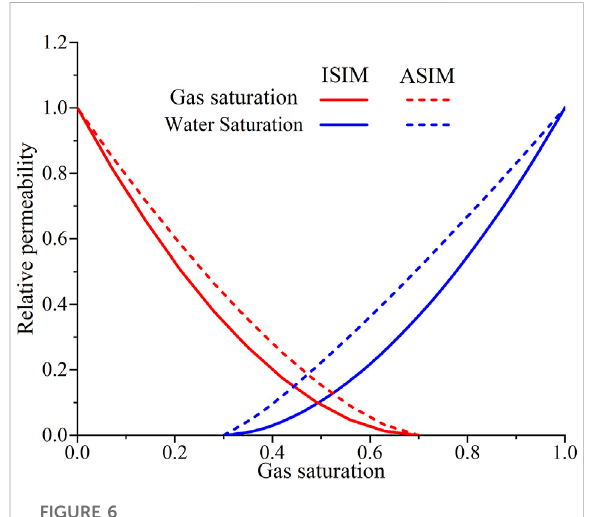
FIGURE 6 The relative permeability curves of gas and water in the ASIM and ISIM